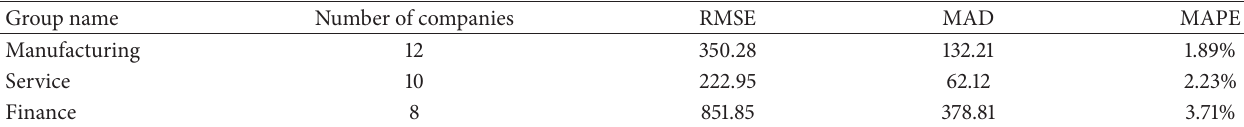
Table 4: The forecasting results of each group by using the K-means-SVR model.